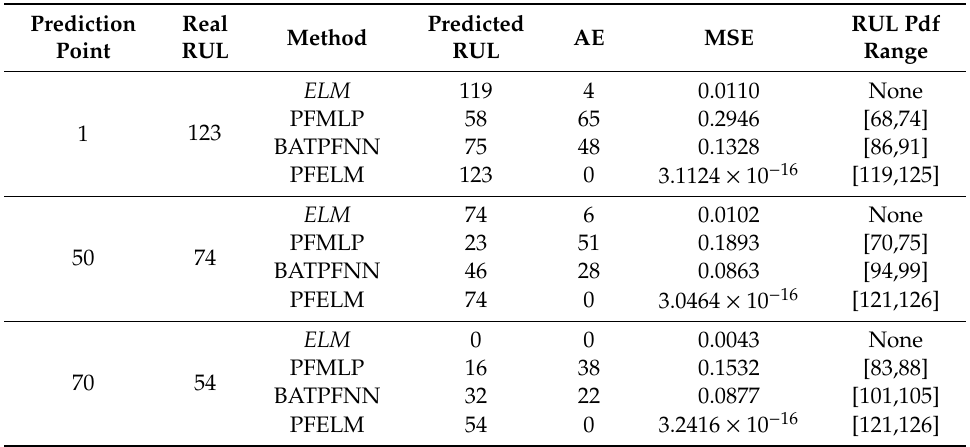
Figure 21. Capacity prediction error from the 70th cycle. Table 4. Comparison of Prognosis Results of B0007.